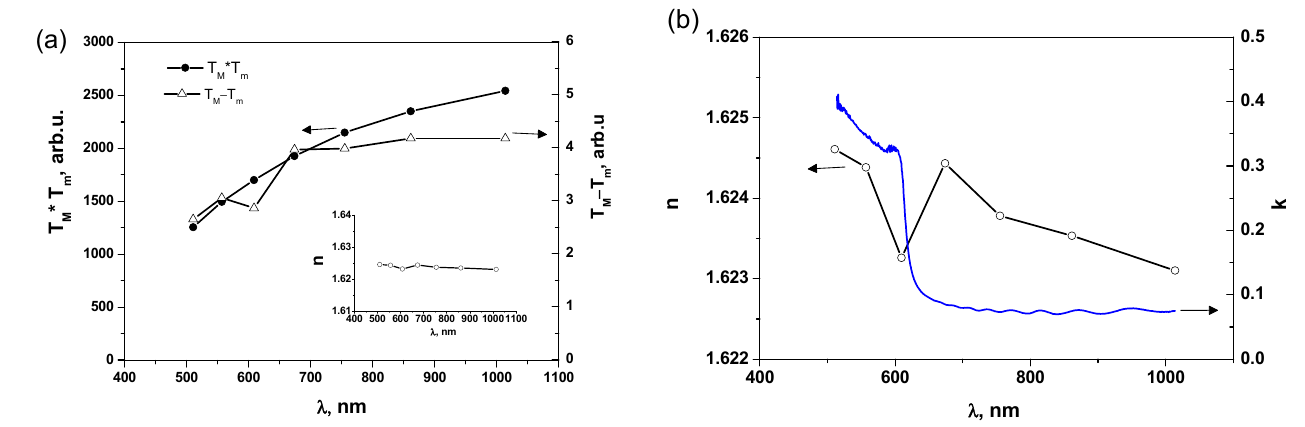
Figure 4. ( a ) Parameters of the optical transmission spectrum for the calculation of the refractive index n and the dependence of the refractive index on the wavelength for the ZnO:Co layer annealed at 400 °C, ( b ) Refractive index n (black line) and extinction coefficient k (blue line). In the visible and near-infrared regions, the refractive index decreases with wave- length, indicating normal dispersion. The calculated refractive index at λ = 700 nm for the ZnO:Co layer annealed at 400 °C is 1.624 (Figure 4b). It is less than the basic value for the